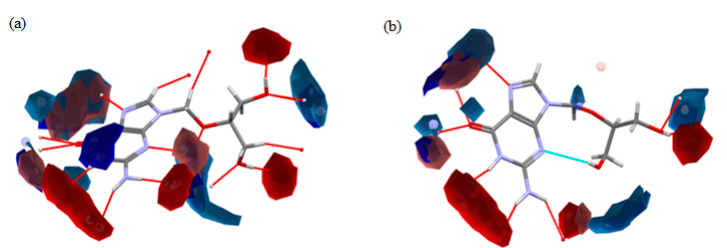
Figure 5. Full interaction map of ( a ) form I and ( b ) form II, with uncharged NH nitrogen (blue), RNH3 nitrogen (light blue), alcohol oxygen (light red) and carbonyl oxygen (red), at level 6.0. The hydrogen bonds predicted by Mercury are also shown (intermolecular, red, intramolecular, turquoise).